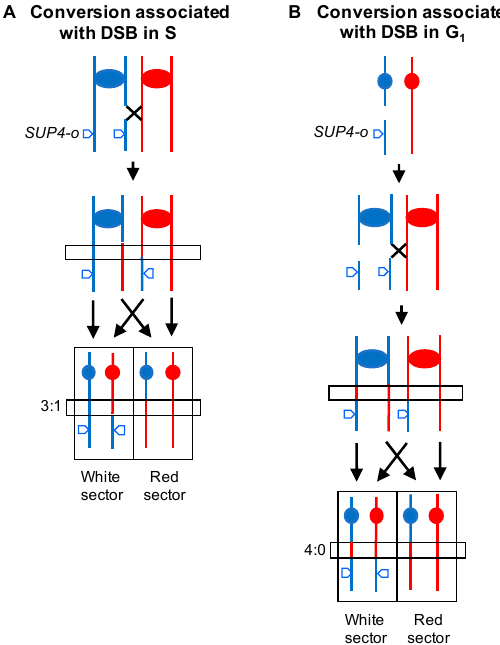
Figure 3. Detecting gene conversion events associated with crossovers initiated in G 2 or G 1 . A diploid is constructed that is heterozygous for an insertion of the SUP4-o ochre suppressing tRNA gene, and homozygous for the ade2-1 ochre-suppressible allele. The diploid forms pink colonies, but derivatives that have zero or two copies of SUP4-o result in red or white colonies, respectively. Thus, crossovers can produce a red/white sectored colony. These sectors are analyzed by SNP arrays to determine the location of the recombination breakpoints. The region of conversion (boxed in the figure) is detected as a difference in the location of the breakpoints in the two sectors. ( A ) Crossover as a consequence of a DSB on one chromatid. As a consequence of the conversion associated with repair of a single broken chromatid, a 3:1 conversion (a region in which 3 of the chromatids contain sequences from the red homolog and one contains sequences from the blue homolog) is observed. ( B ) Crossover reflecting the repair of two DSBs. We show a broken chromosome that is replicated to yield two chromatids broken at the same position. The conversion tracts associated with these repair events result in a 4:0 region. To explain the pattern of LOH, we suggest that one break is repaired to generate a crossover, and the second is repaired to produce a conversion event unassociated with a crossover.